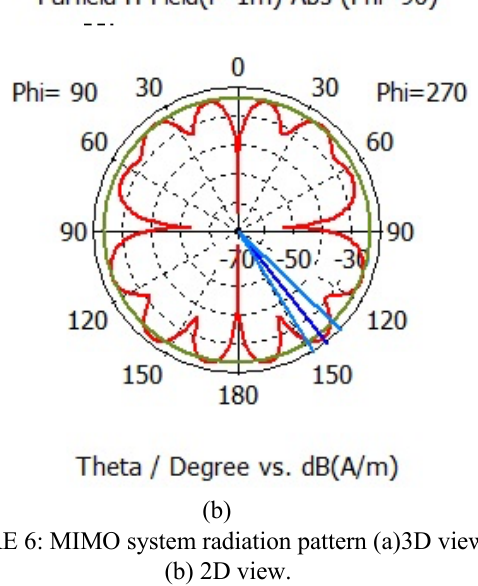
FIGURE 6: MIMO system radiation pattern (a)3D view and (b) 2D